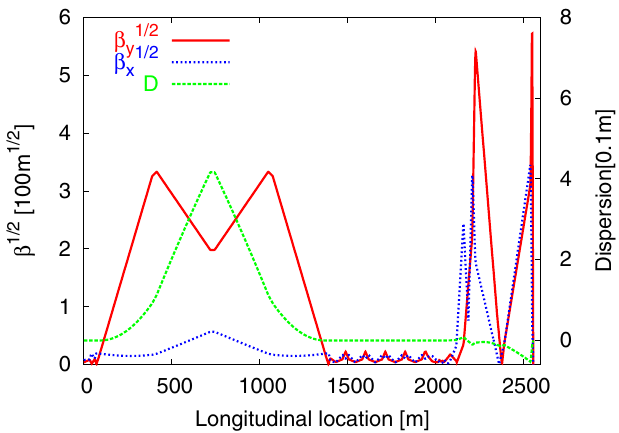
FIG. 1. (Color) Twiss functions of the CLIC beam delivery